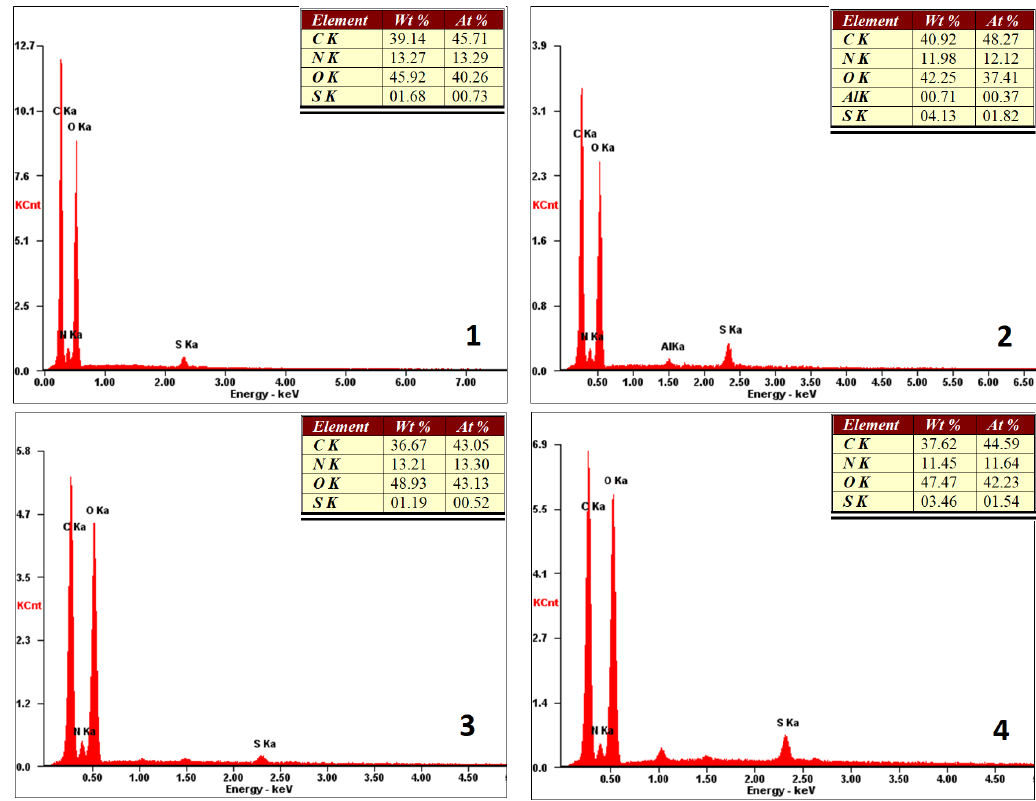
Figure 6. XRF microanalysis of the prepared scaffold surfaces (sample 1—chitosan crosslinked with adipic and malonic acid; sample 2—chitosan crosslinked with adipic and L -glutamic acid; sample 3—chitosan crosslinked with adipic, L -glutamic and malonic acid; sample 4—chitosan crosslinked with adipic and levulinic). Molecules 2017 , 22 , x FOR PEER REVIEW